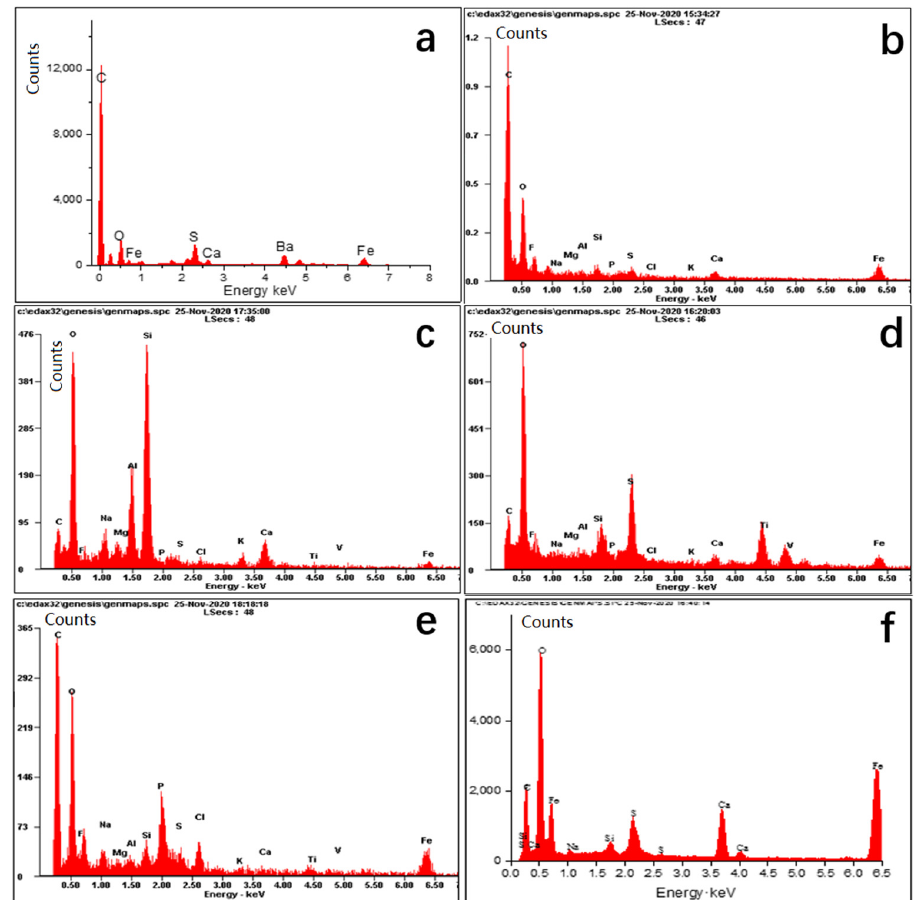
Figure 4. The EDS spectrum of scale samples of six gas wells ( a – f ) represents the EDS spectrum of scale sample ( a ), sample ( b ), sample ( c ), sample ( d ), sample ( e ), and sample ( f ), respectively). Table 1. The speculated compositions of each scale.